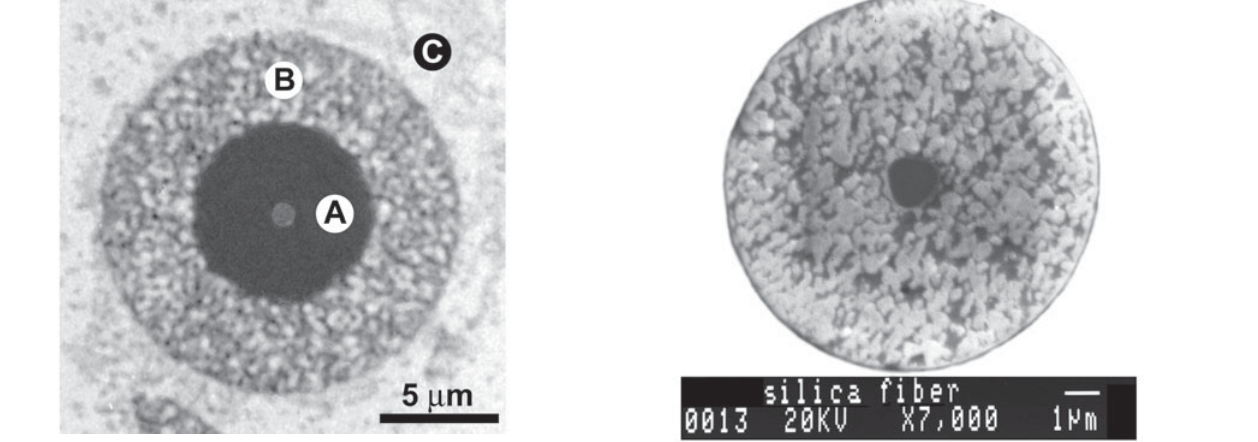
Figure 1. Optical microscopy in a polished sample showing a de- tail of a fiber partially reacted (B), the center fiber with untrans- formed silica (A) and the matrix aluminium (C).